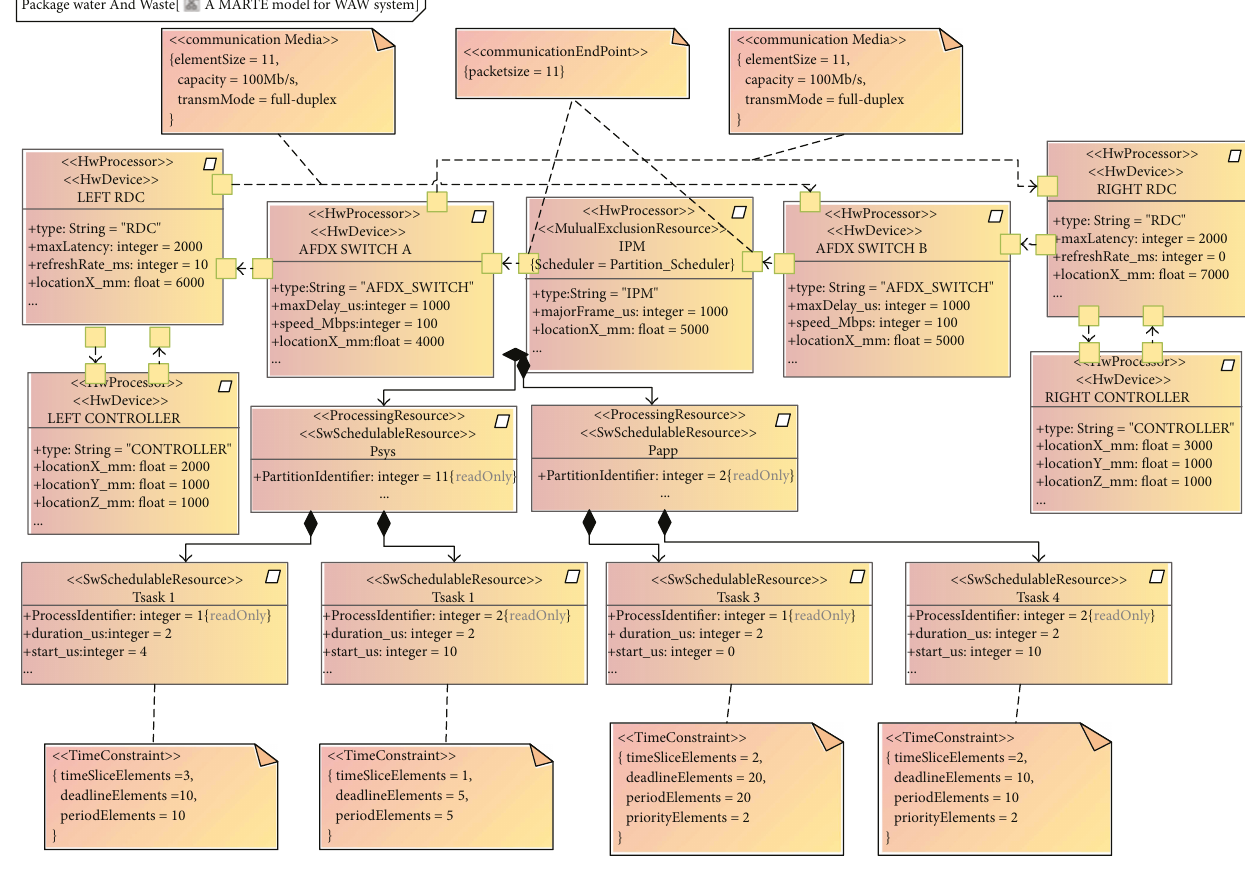
Figure 23: A MARTE model for WAW system.